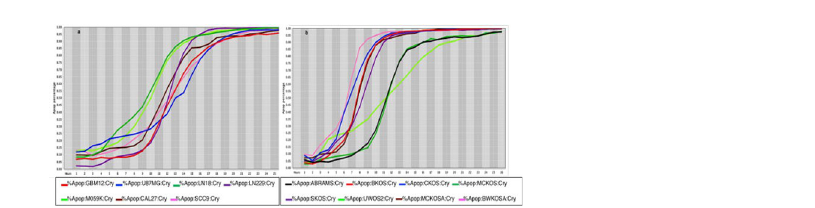
Fig 4. Cell death response curves for glioblastoma and canine osteosarcoma. 4a –Cell death response expressed in percentage of apoptosis in human glioblastoma (GBM12- red line, U87MG- blue line, LN18- dark green line, LN229- purple line, M059K - neon green line) and squamous cell carcinoma cell lines (CAL27- black line, SCC9- pink line) exposed to CT at 20 μ M concentration. 4b –Cell death response expressed in percentage of apoptosis in canine osteosarcoma cell lines exposed to CT at 20 μ M concentration (ABRAMS- black line, BKOS- red line, CKOS- blue line, MCKOS- dark green line, SKOS- purple line, UWOS-2- neon green line, MCKOSA- brown line, BWKOSA- pink line).